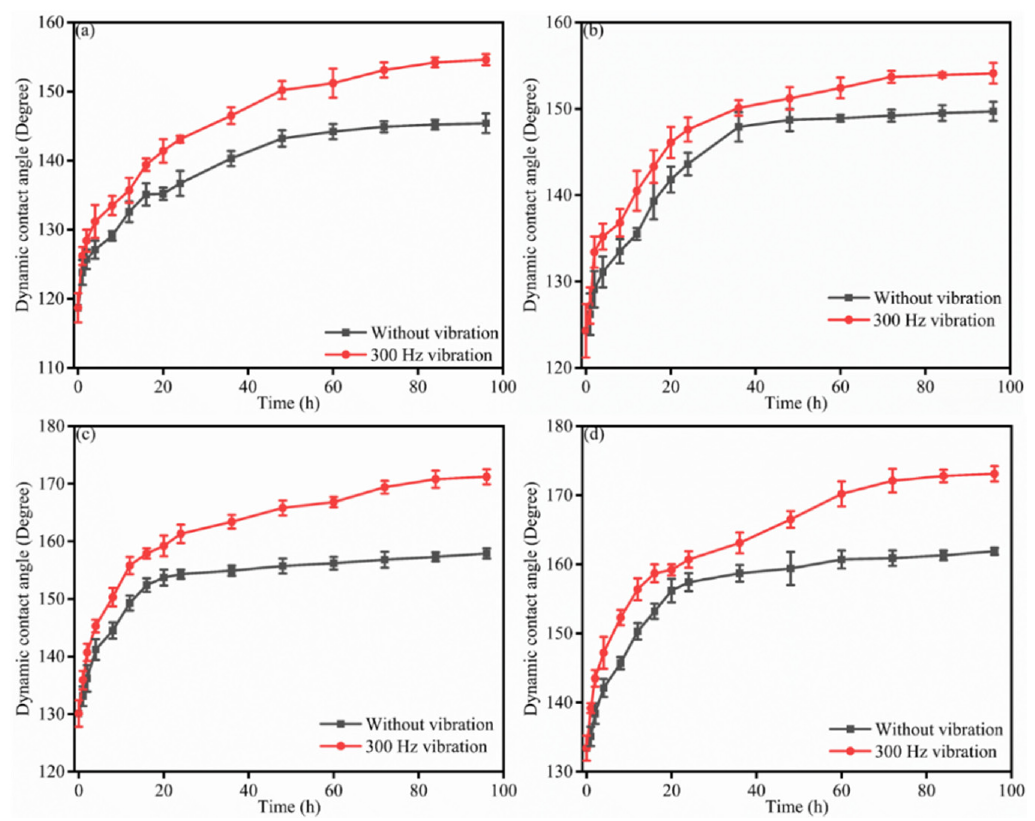
Figure 6. The water/solid/toluene dynamic contact angles of water drops onto the ( a ) iron casting; ( b ) steel; ( c ) PVC; ( d ) PE, with or without 300 Hz